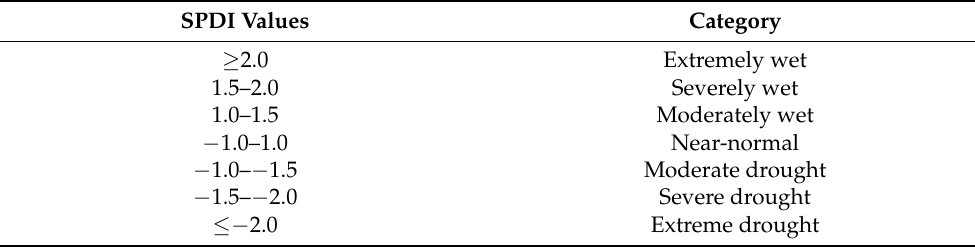
Table 2. Categories resulting from SPDI estimation, adapted from McKee et al. [34] and WMO [37].